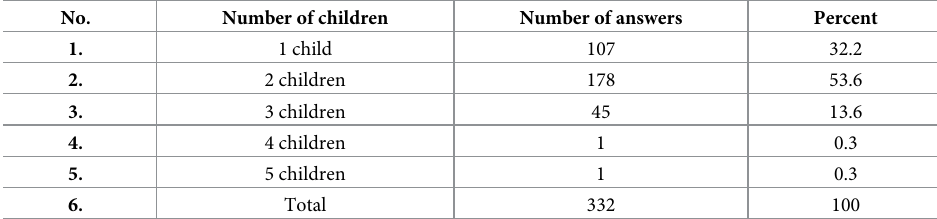
Table 7. Number of children the studied mothers have. N = 334 (no data for 2 mothers). Source: Study by Ewa Krause. No. Number of children